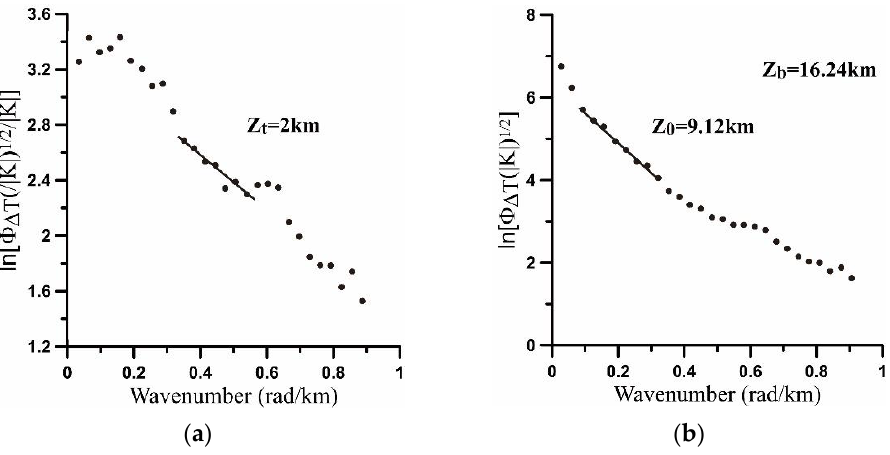
Figure 4. Average power spectrum scheme for CPD estimated in the study area beneath the central part of the Eratosthenes Seamount: ( a ) top depth in the study area; ( b ) centroid depth in the study area.